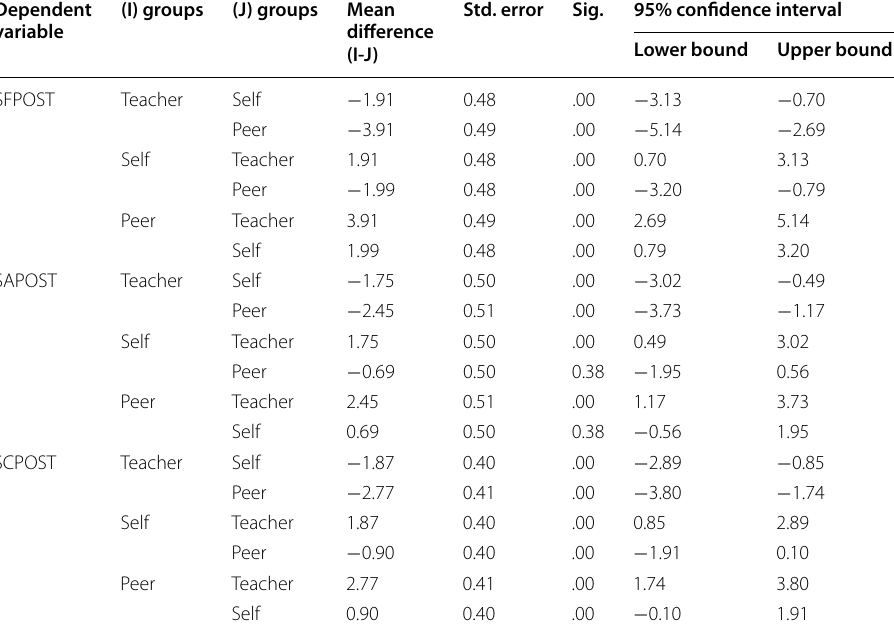
Table 5 Post hoc Scheffe test (all groups’ posttests of speaking accuracy, fluency, and complexity) Dependent